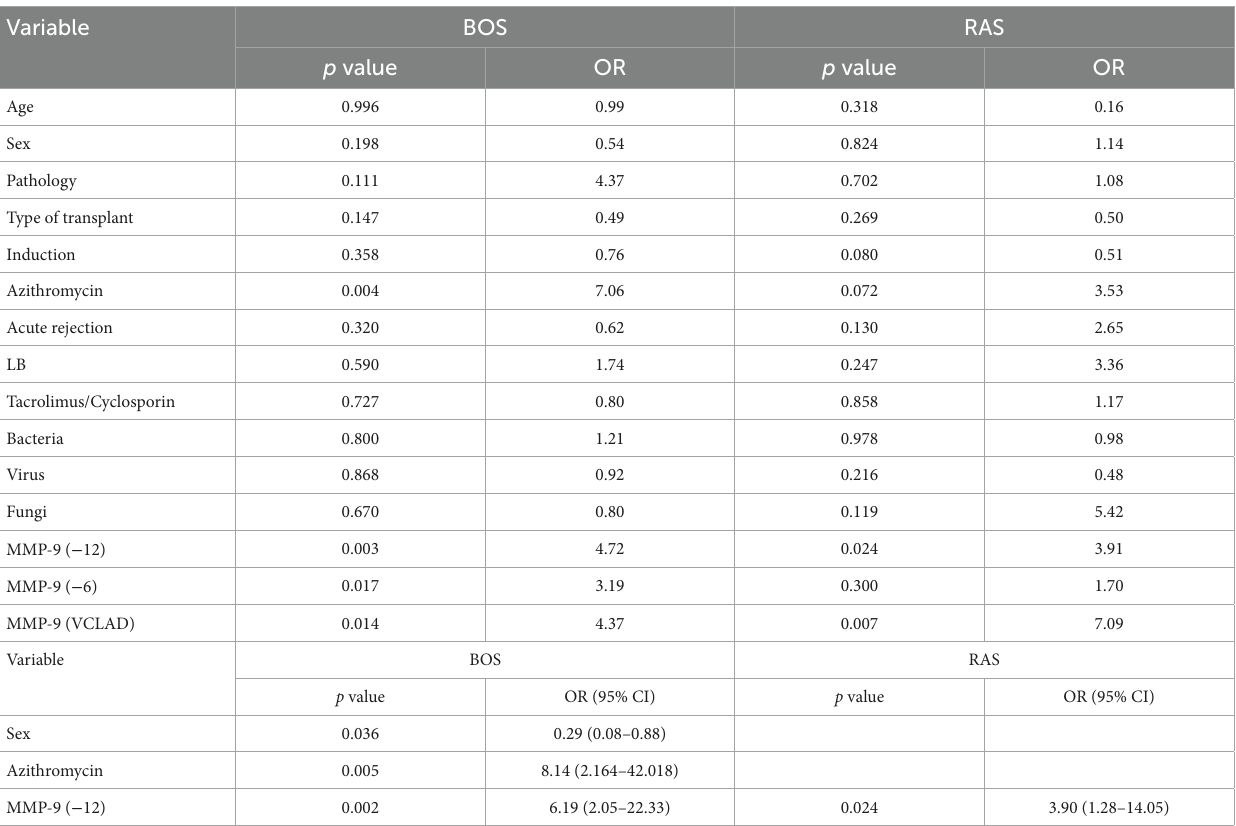
TABLE 2 Univariate and multivariate analyses of risk factors for CLAD adapted from